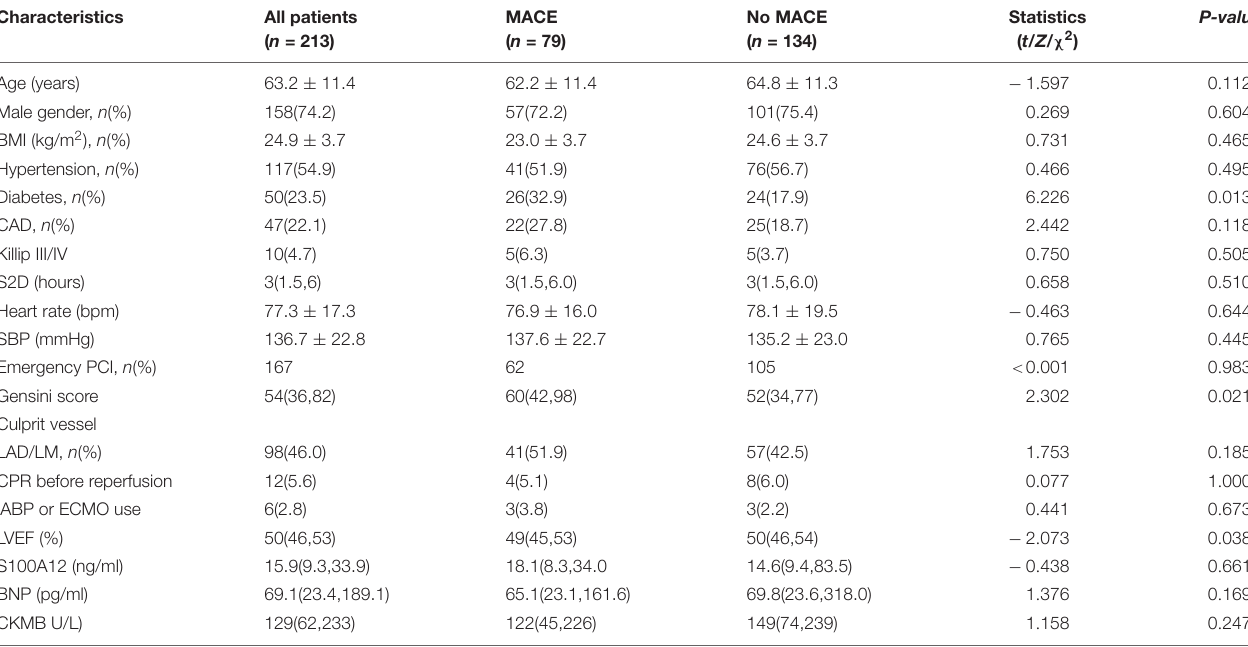
TABLE 4 | Clinical characteristics of patients with MACE during follow-up in our validated cohort. Characteristics